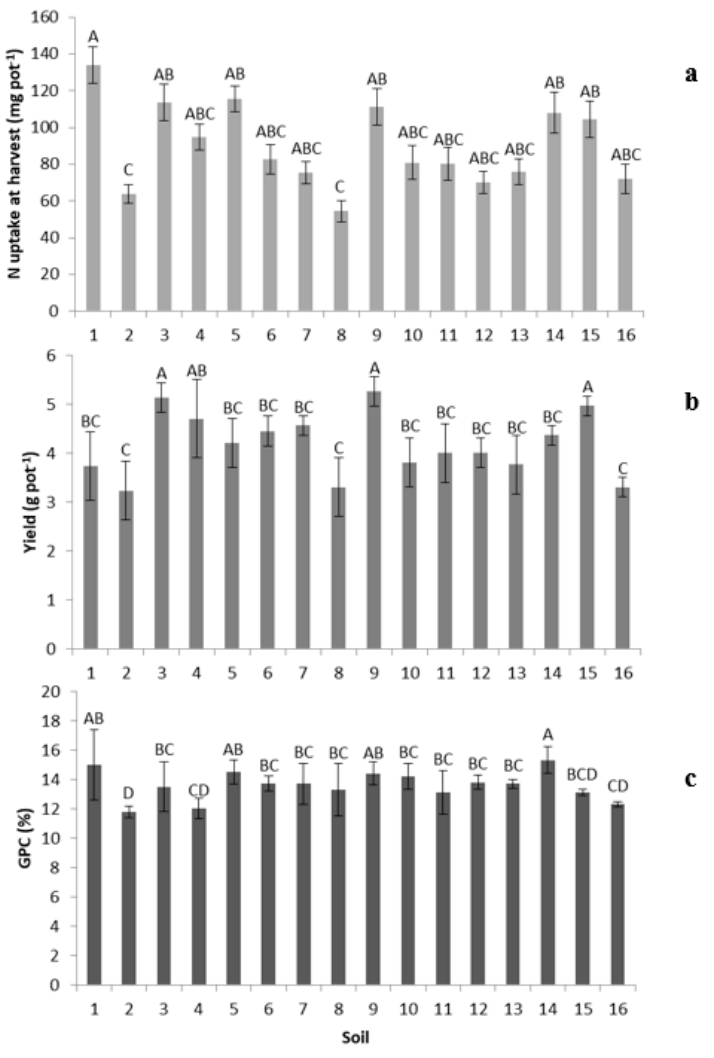
Figure 1. ( a ) Wheat N uptake at harvest (mg pot − 1 ), ( b ) yield (g pot − 1 ), and ( c ) GPC (%) in 16 soils from Araba. Different letters represent significant differences ( p ≤ 0.05) among soils. Values are the mean of three replicates ± SD.